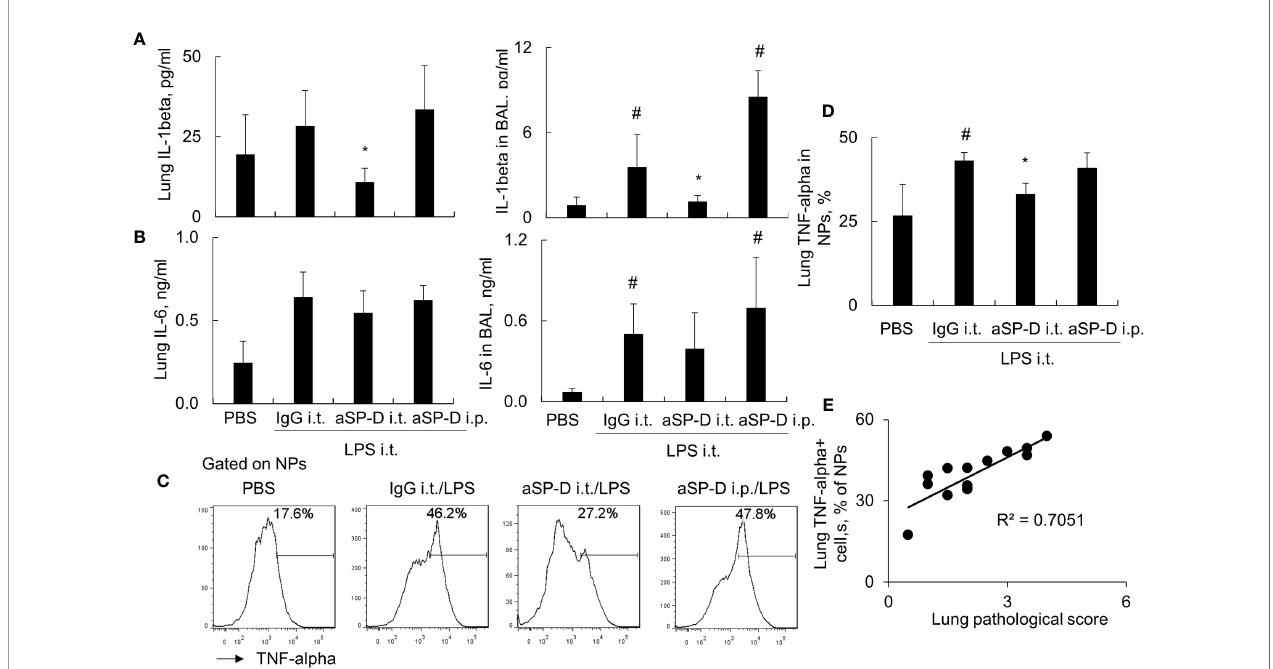
FIGURE 8 | Intratracheal administration of anti-surfactant protein D (aSP-D) suppressed the expression of pro-in fl ammatory cytokines in mice with acute lung injury (ALI). (A, B) ELISA assay for the expression of interleukin (IL)-1beta and IL-6 in lung extracts and bronchoalveolar lavage (BAL) of each group. *p < 0.05 vs . immunoglobulin G (IgG)/lipopolysaccharide (LPS) group; # p < 0.05 vs . phosphate buffered saline (PBS) group. (C) Intracellular staining for tumor necrosis factor (TNF)-alpha expression in neutrophils. TNF-alpha+ neutrophils (NPs) were gated on NPs. Representative histogram of each treatment was shown. (D) Quantitative analysis of TNF-alpha+ NPs. (E) Correlation analysis between TNF-alpha+ NPs and lung pathological score. Each dot presents the value of an individual